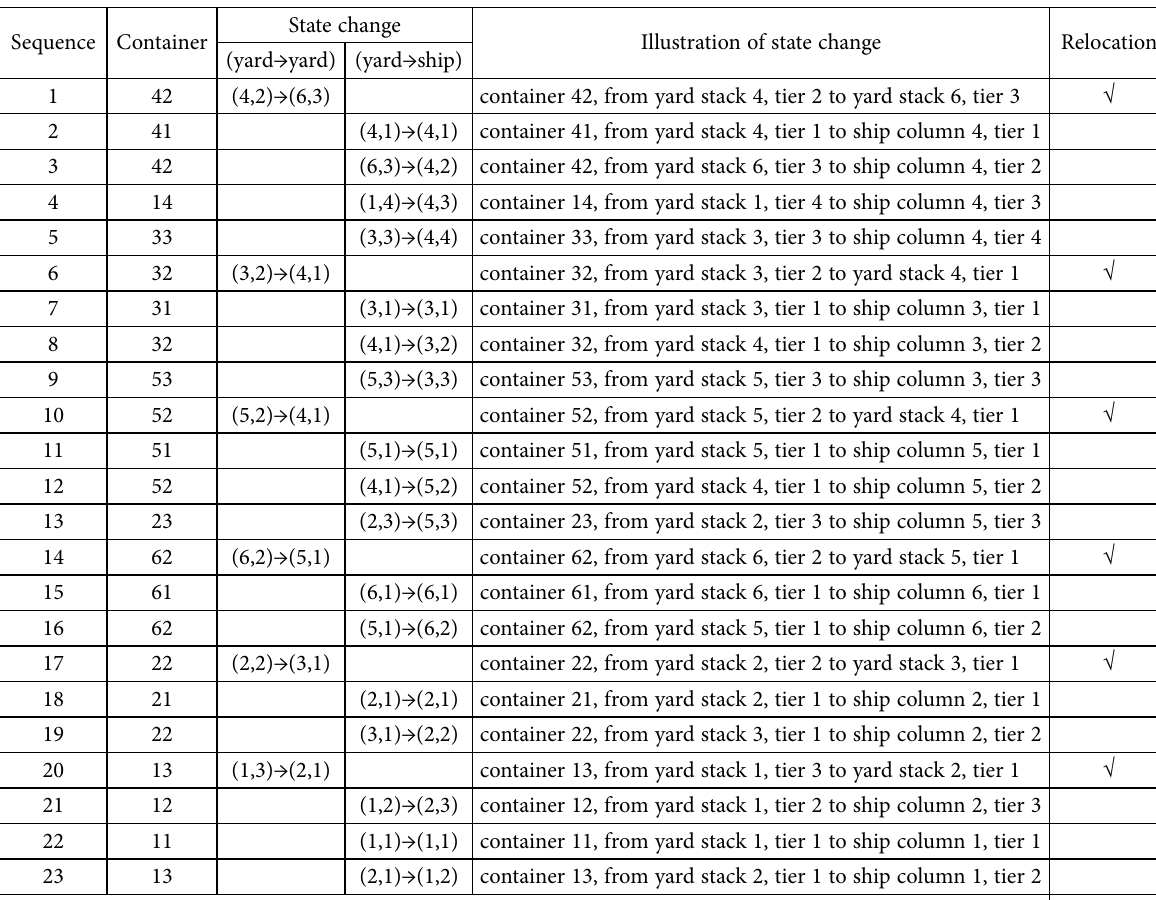
Table 3. Details of loading sequence based on hybrid dynamic programming